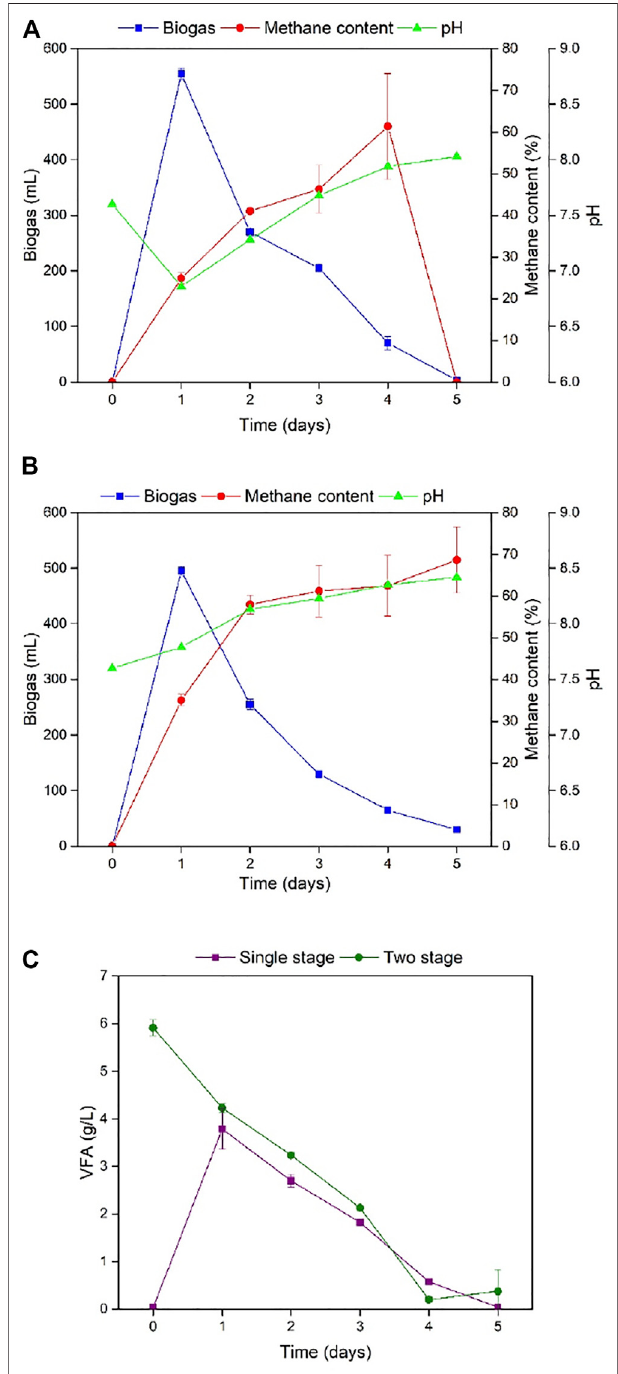
FIGURE 3 | Daily biogas production, methane content, and pH for (A) SS-ADand (B) TS-AD; (C) VFAaccumulationforSS-ADand TS-AD(SS-AD= Single stage anaerobic digestion, TS-AD = Two stage anaerobic digestion; VFA = Volatile fatty acids).